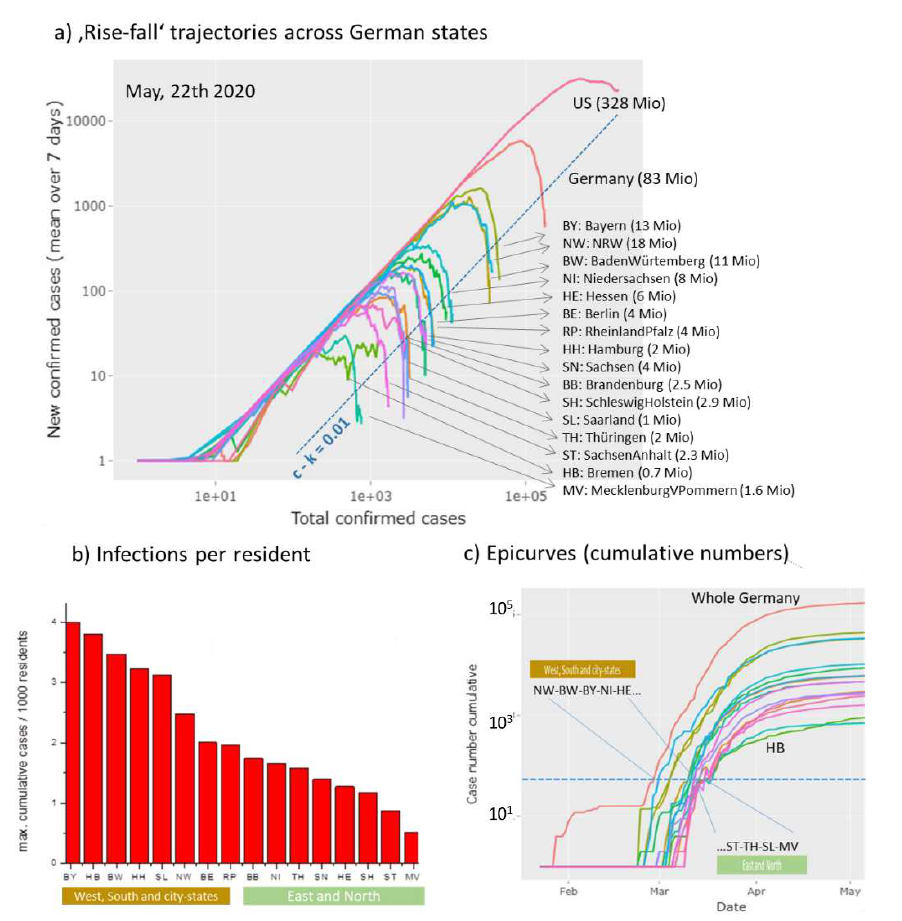
Figure 8. Covid-19 in Germany: ( a ) ‘Rise-fall’ trajectories across German states: The trajectories of German states resemble that of whole Germany indicating similar dynamics of Covid-19 across Germany. Trajectory of US is shown for comparison. ( b ) The relative maximum cumulative number of infected cases (per 1000 residents of the respective states divides clearly into states from West and South Germany and states in the East and North of Germany. City states (BE, HH, HB) are found in the former group. ( c ) Epi-curves (cumulative case numbers as a function of time) reveal that epidemic arrived earlier in Western and Southern states mostly by a few days compared with the Eastern and Northern ones. The curve of the city state Bremen (HB) slightly di ff ers from that of the other